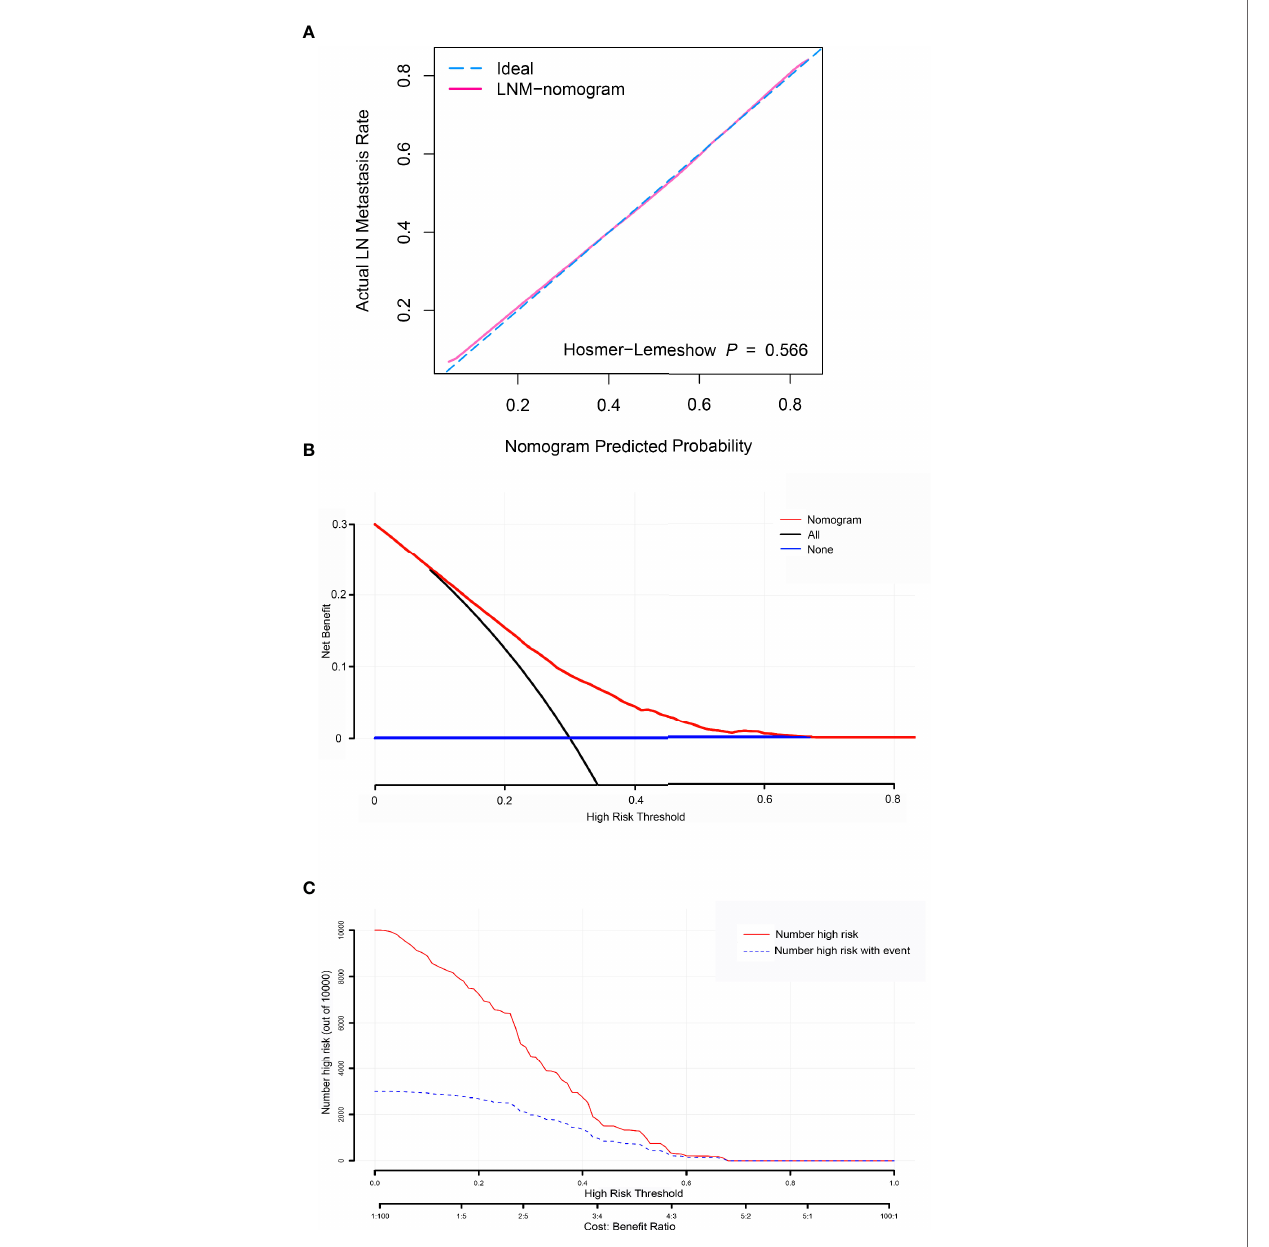
FIGURE 3 | Calibration curve, decision curve analysis (DCA), and clinical impact curve for predicting lymph node metastasis (LNM) in patients with bladder cancer. (A) Calibration curve of positive lymph node probability nomogram in the veri fi cation set (bootstrap method, 1000 repetitions). (B) The DCA curve of the veri fi cation set. The x-axis and y-axis mean the threshold probability and net bene fi t, respectively. The black line indicates all patients experienced LNM, and the blue line indicates no patient developed LNM. (C) Clinical impact curve of the veri fi cation set. The red curve demonstrates the number of people classi fi ed as positive by the nomogram under each threshold probability, and the blue curve is the number of true positives under each threshold